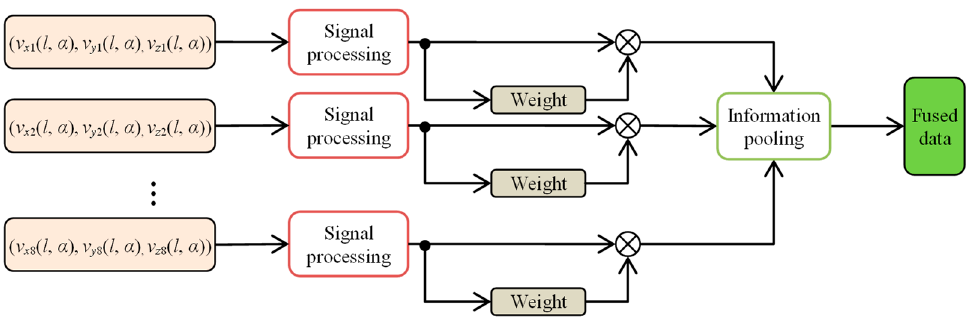
Figure 12. Block diagram of the data fusion process: Stage I.